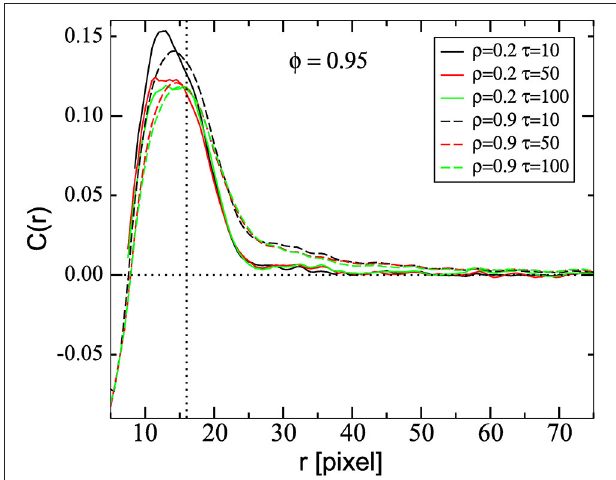
FIGURE 6 | Average spatial correlation function of the velocities, C ( r ), as a function of the distance r between cell pairs, for two different densities, ρ = 0.2 and 0.9 (continuous and dashed lines, respectively) and different values of τ , as indicated, and φ = 0.95. The vertical dashed line represents the average cell diameter equal to 16 µ m as discussed in section 2.2. Data was obtained by averaging between 0 and 4,000 MCS and over 50 and 10 samples, for ρ = 0.2 and 0.9,